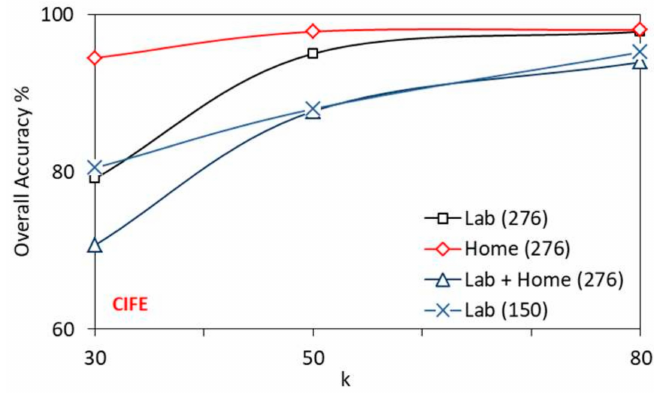
Figure 12. Performance of CIFE with k on di ff erent